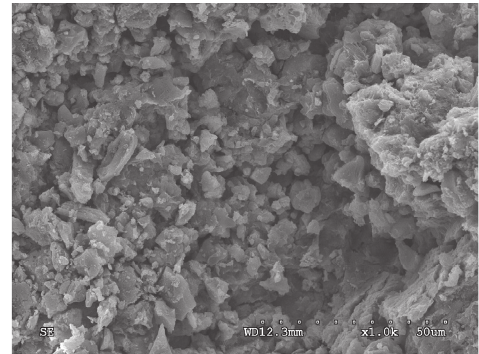
Figure 7: The soil of curing 0d and being magnified 1000